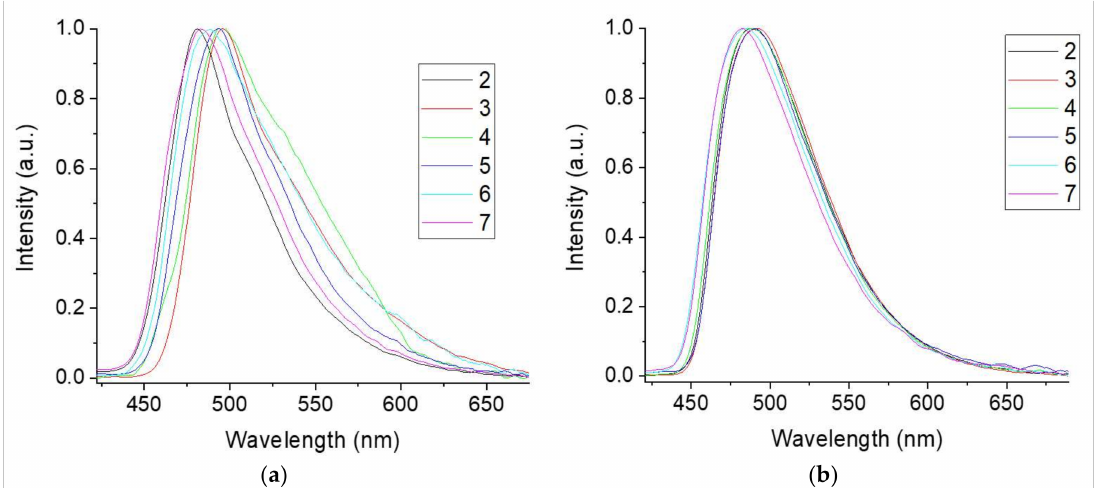
Figure 6. Luminescence spectra of the samples 2 – 7 : ( a ) powders (sample 4 was an oil), ( b ) DMSO solutions (1000 µ M).